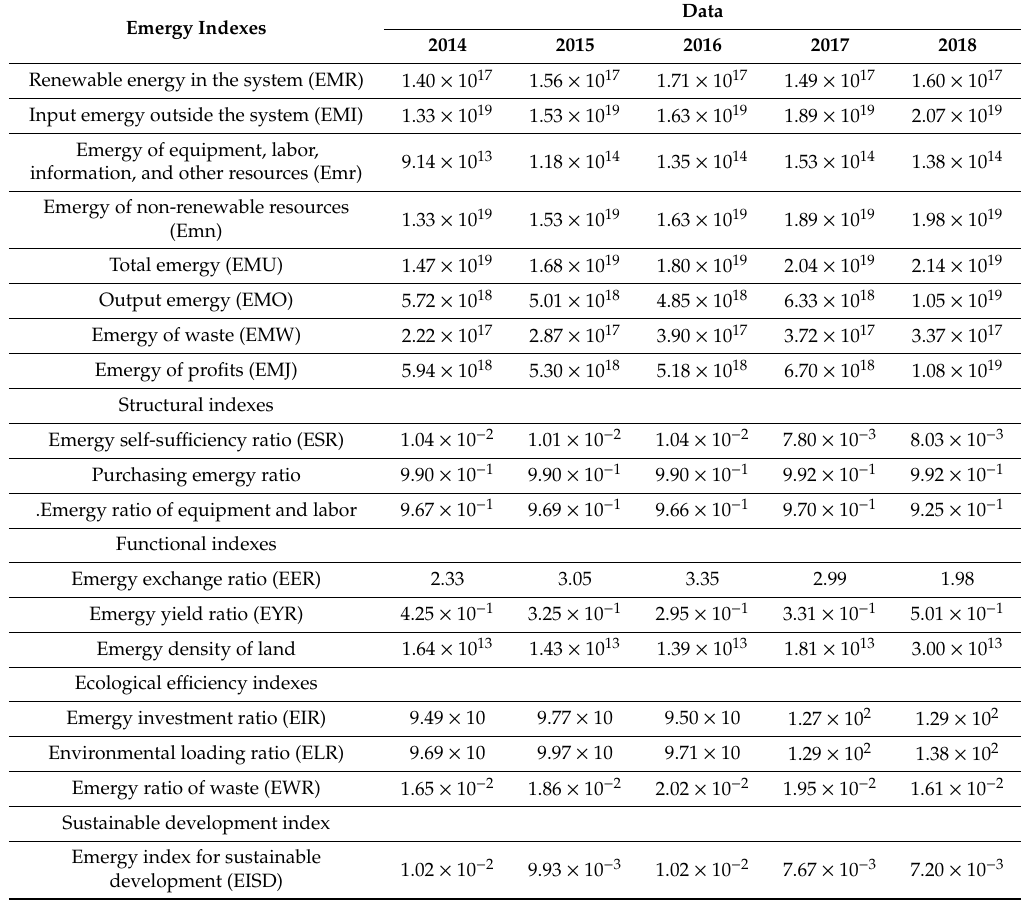
Table 4. The sustainable development evaluation index data of the logistics